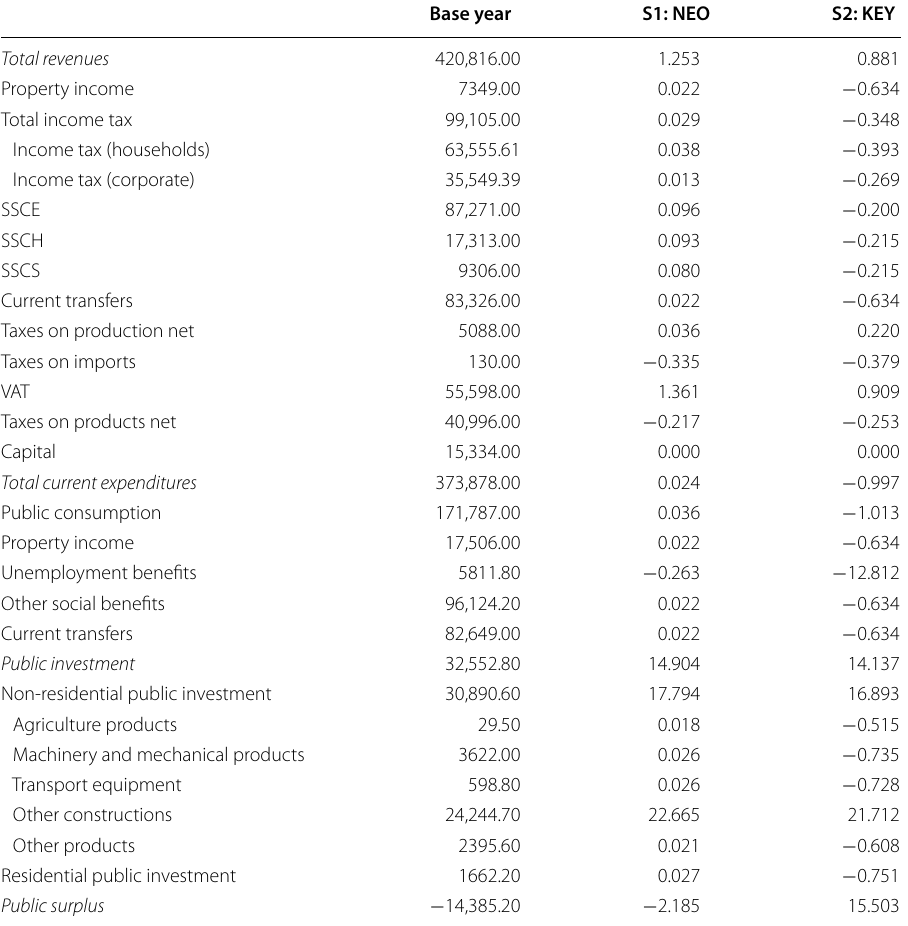
Table 4 Public revenues and expenditures (in percentage